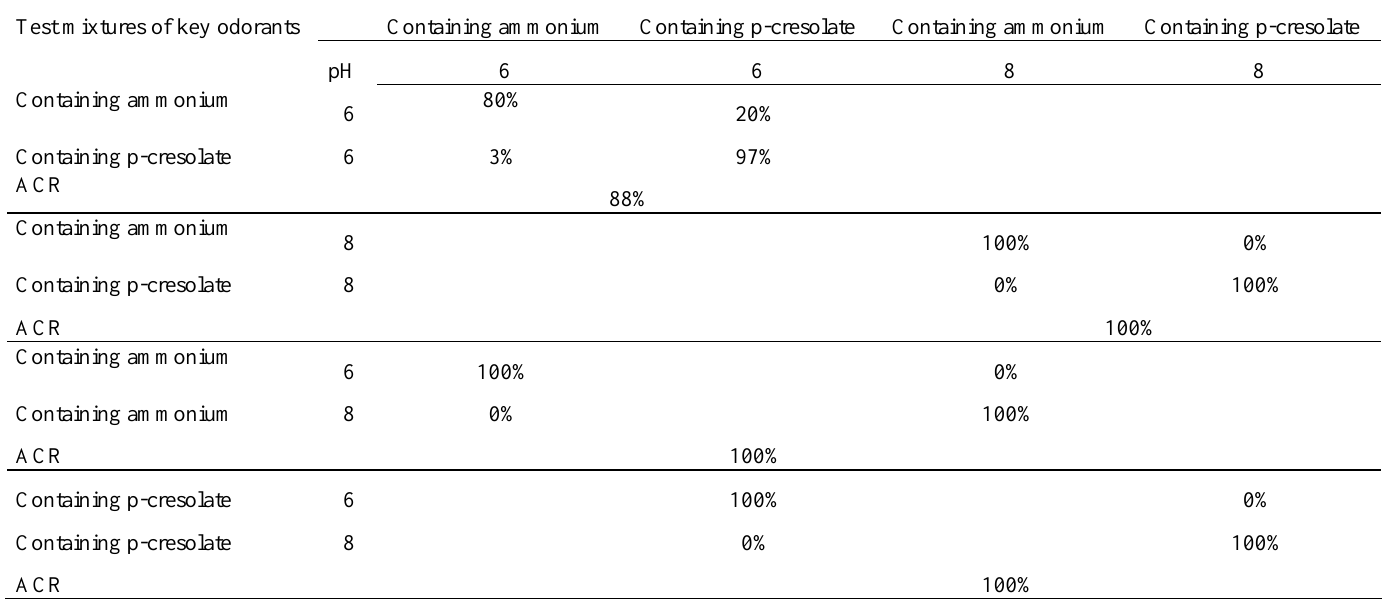
Table 3. Classification rates and average classification rate (ACR) for validation sets of test mixtures of key